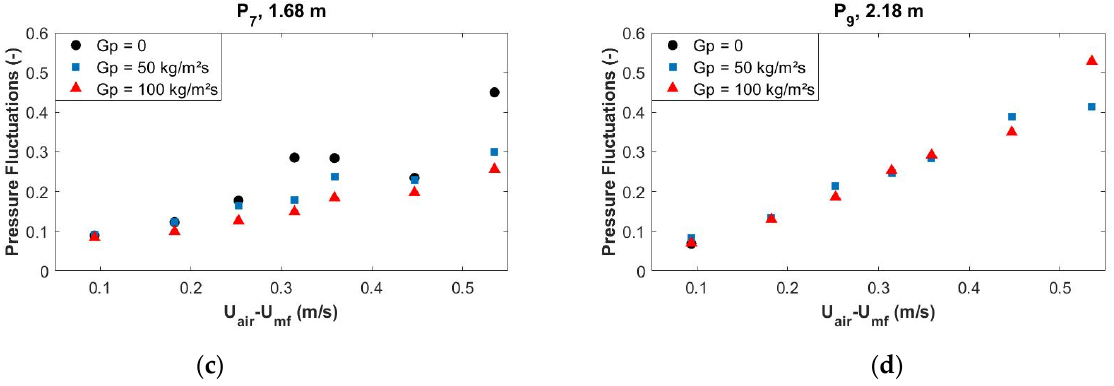
Figure 17. Evolutions of the pressure fluctuations with superficial excess air velocity (calculated at the level of the aeration), for three particle mass flux configurations, at fixed heights: ( a ) 0.18 m, ( b ) 0.93 m, ( c ) 1.68 m and ( d ) 2.18 m.